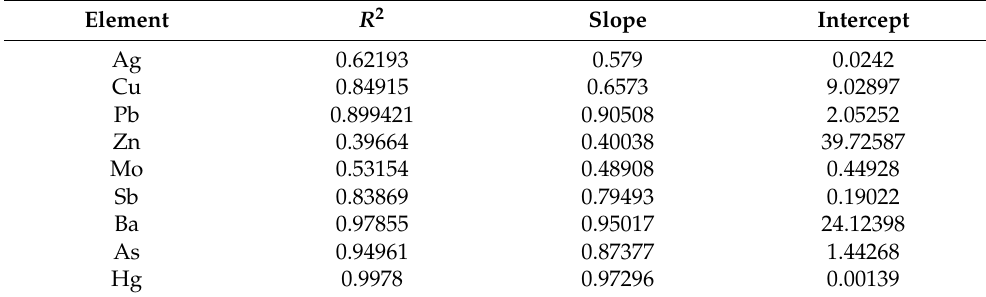
Table 3. Fitting results of measured values and simulated predicted values of soil element content.